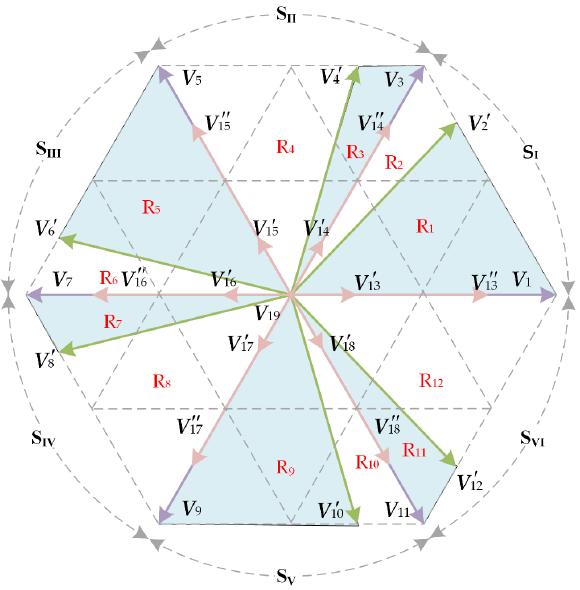
Figure 5. Space vector diagram of three-level converter for d 1 = 0.5 and d 2 = 1.5.